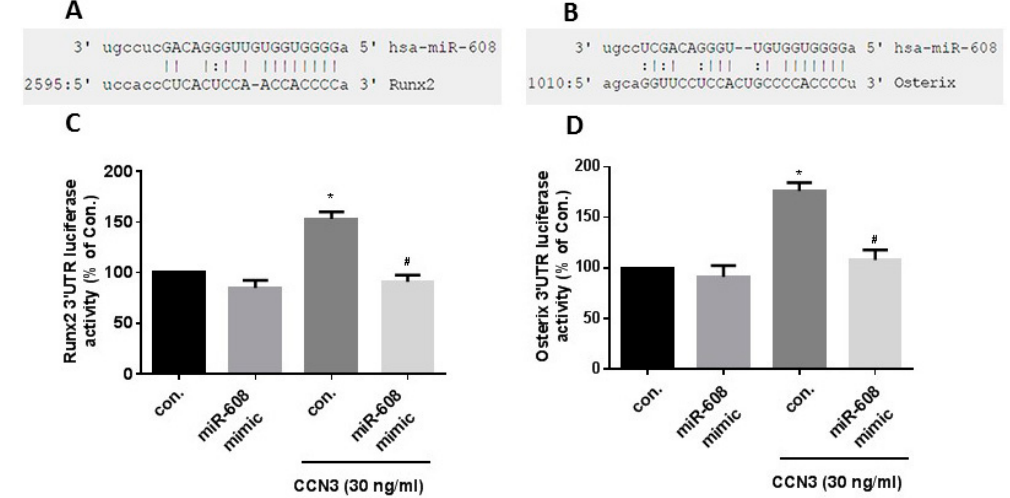
Figure 4. The binding of miR-608 to Runx2 and osterix three prime untranslated region (3 ′ -UTRs) mitigated CCN3-induced increases in Runx2 and osterix expression. ( A , B ) Diagram of the miR-608 binding sites in the Runx2 and osterix 3 ′ -UTRs. ( C , D ) Osteoblasts were transfected with the Runx2 or osterix 3 ′ -UTR plasmids, with or without miR-608 mimic, then stimulated with CCN3. Luciferase promoter activity was expressed as relative luciferase activity. Results are expressed as the mean ± S.E. * p < 0.05 as compared with the control group; # p < 0.05 as compared with the CCN3-treated group.